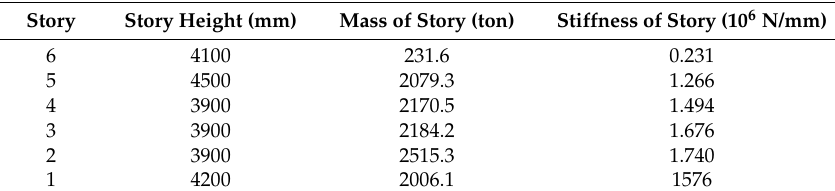
Table 1. Parameters of story.